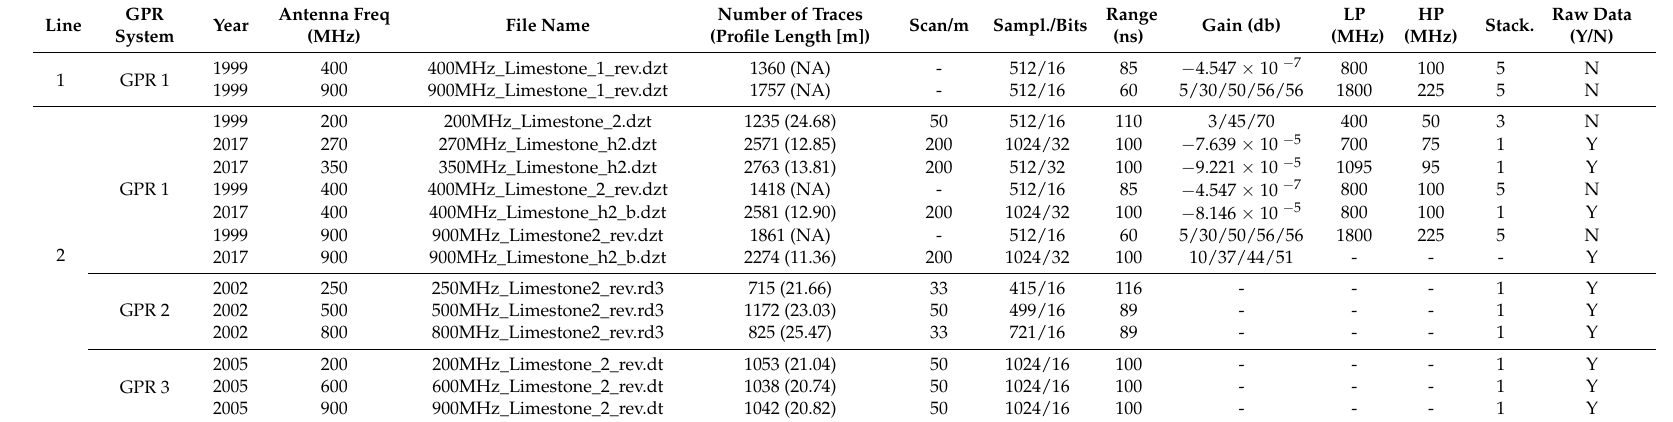
Table 5. Information about data collected in the limestone region. NA means not available.